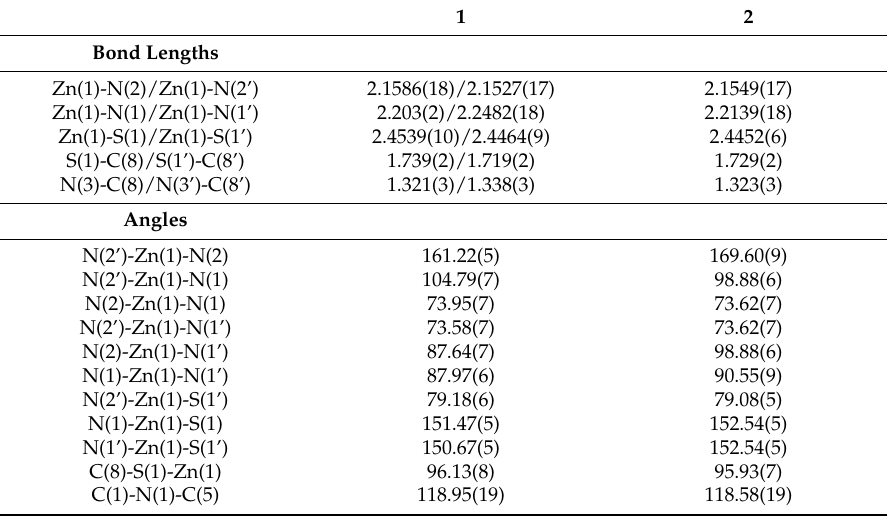
Table 1. Selected bond lengths (Å) and angles (°) for [Zn(atc-Et) 2 ] ( 1 ) and [Zn(atc-Ph) 2 ] ( 2 ).